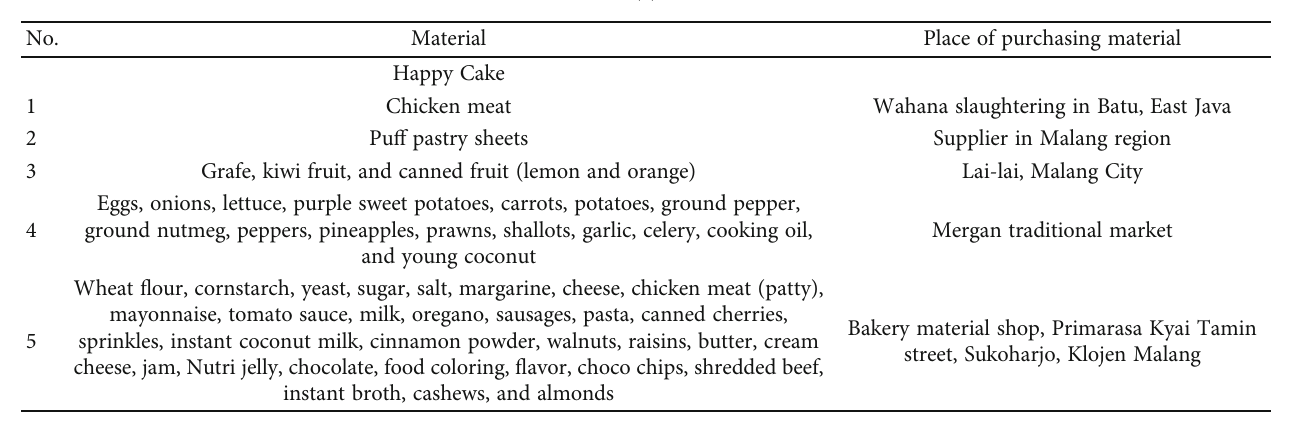
Figure 3: Sugar metabolism in the dough. Modi fi ed after [44, 45]. Table 4: Material purchase data.